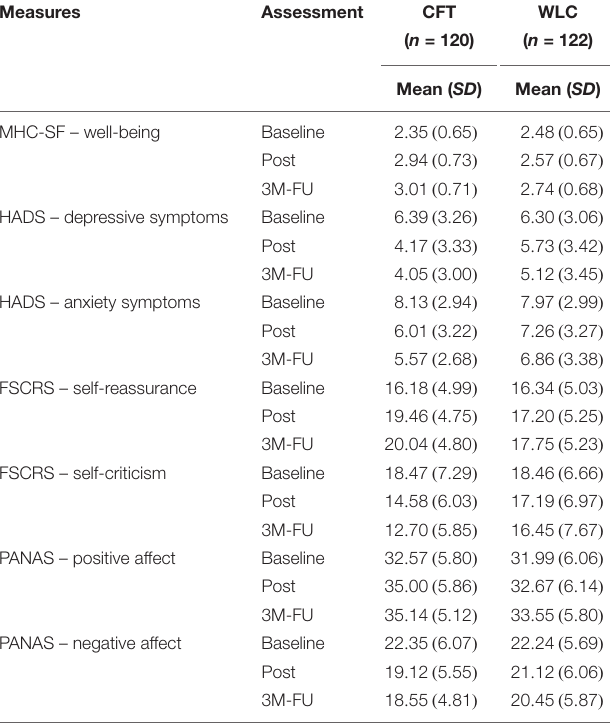
TABLE 2 | Means and SD s of mediating and outcome